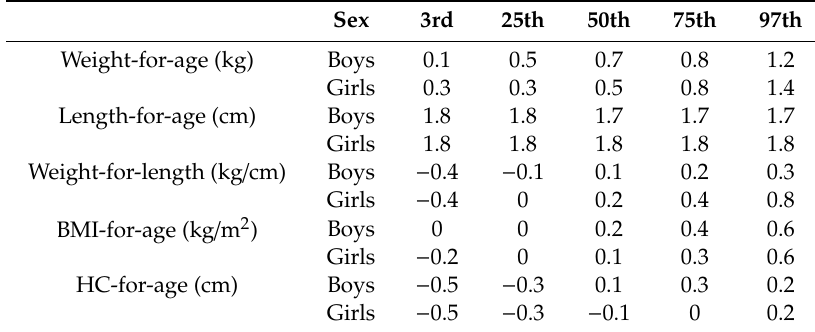
Table 1. Di ff erences between WHO percentiles and smoothed centile curves at 24 months of age for length-for-age, weight-for-age, weight-for-length, body mass index-for-age, and head circumference-for-age, for boys and girls